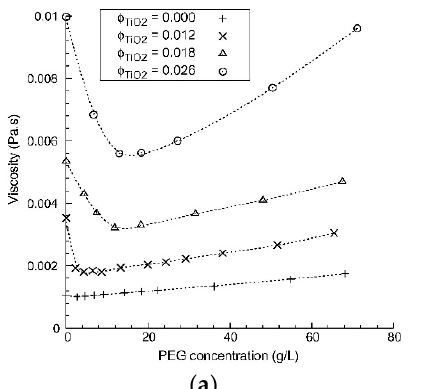
Figure 7. Effect of dispersant ( a ) concentration [50] and ( b ) type [51] on the viscosity of different nanofluids.